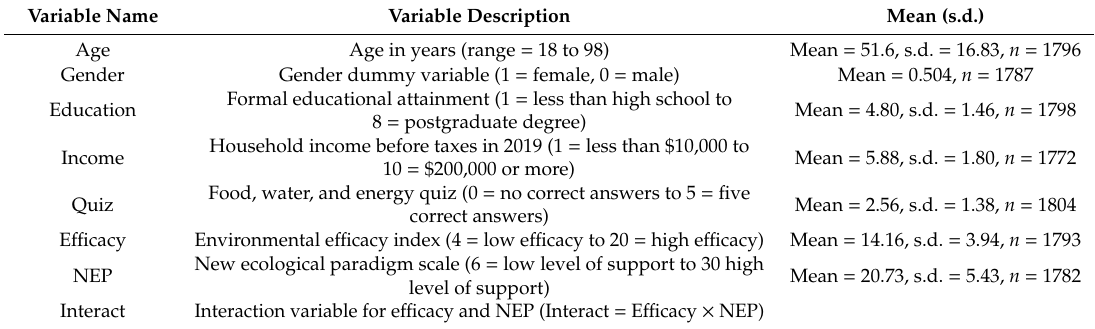
Table 3. Independent and control